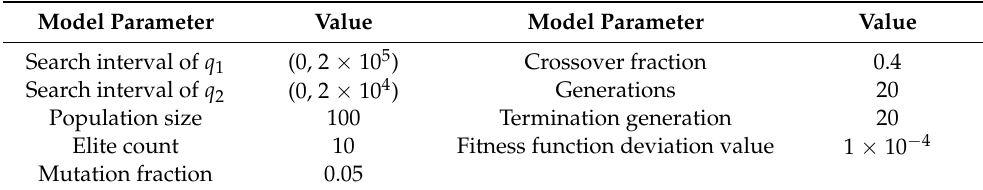
Figure 5. Optimization results of GA: ( a ) the variation in fitness function value; ( b ) optimal solution of weighting coefficients. Table 2. Parameters of